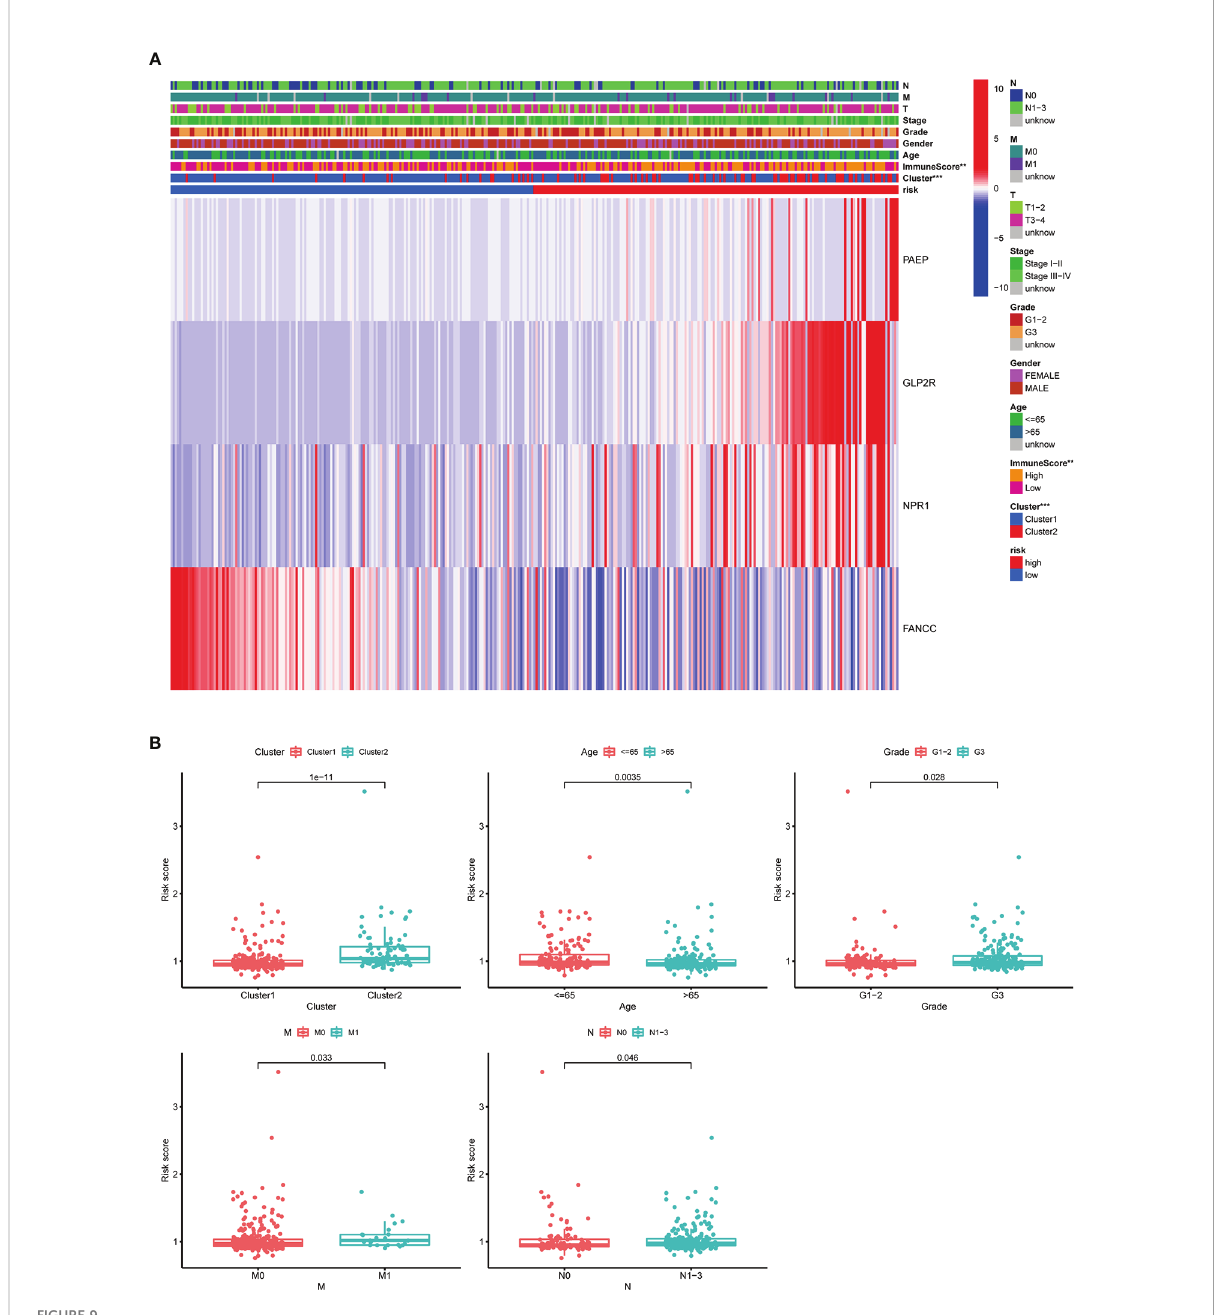
FIGURE 9 The relationship between RS and clinicopathological characteristics, and TME. (A) The heatmap showed the expression of 4 prognostic m 6 AIGs, the distribution of clinicopathological characteristics, and the immune scores of TME in different risk subgroups. ** p < 0.01, *** p < 0.001. (B) Signi fi cant differences in RS were observed between different clusters, age, stage M, stage N, and different tumor